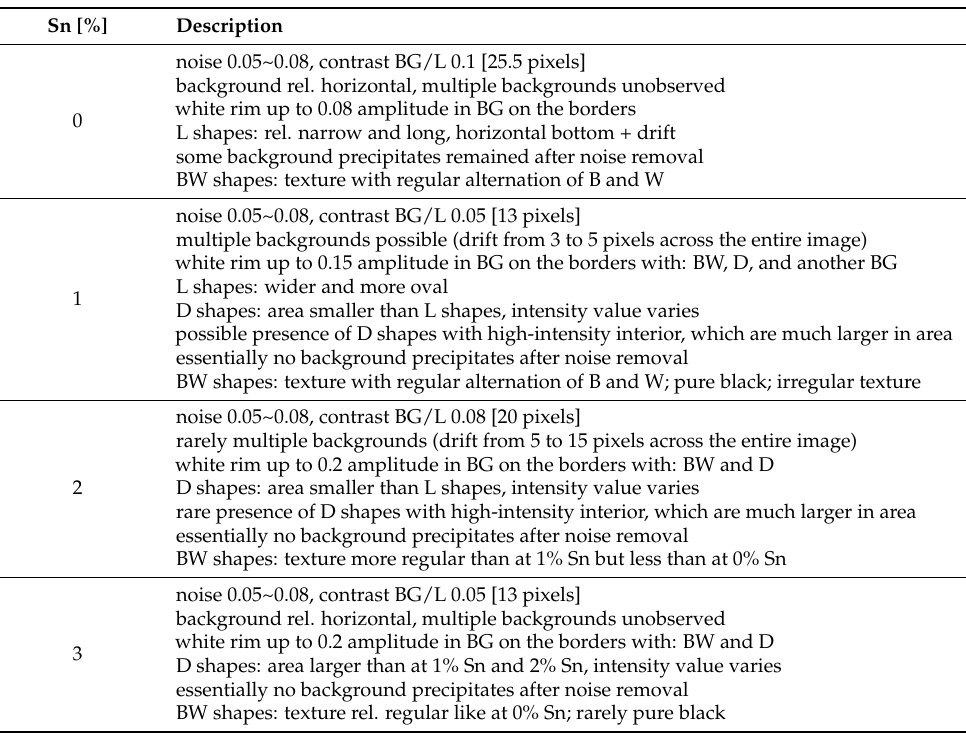
Figure 5. NLM filter operation. Table 5. Typical data features,